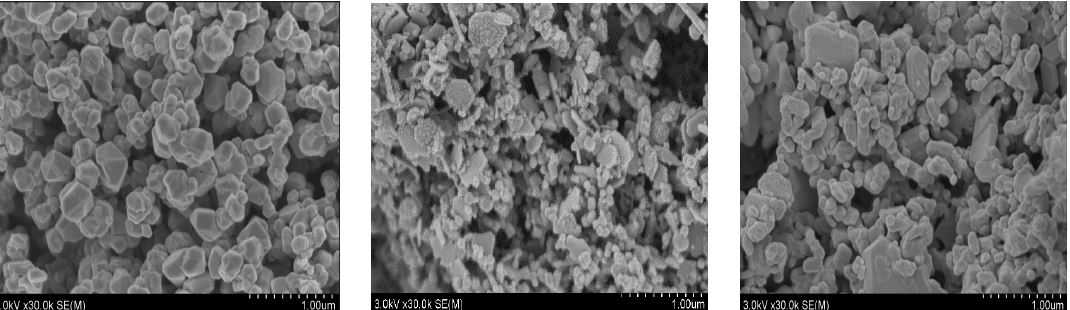
Figure 12. SEM images of the silver powders reduced by ascorbic acid from the HNO 3 solution with several pH (6, 8, 10) at 30 °C.